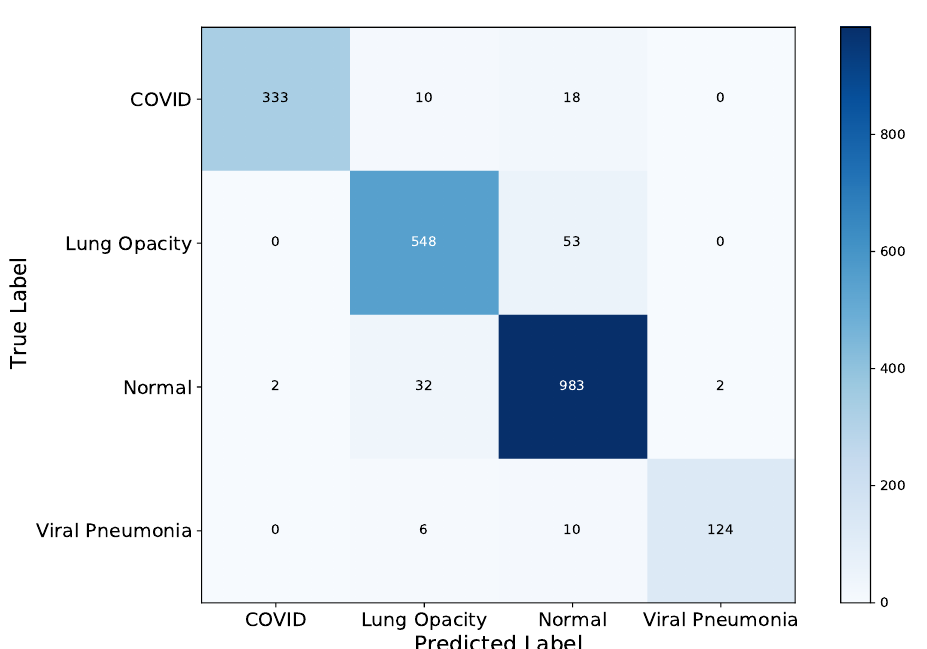
Figure 11. VGG-19 Test Confusion Matrix, where most X-ray images were classified correctly with few misclassifications for COVID-19 class.